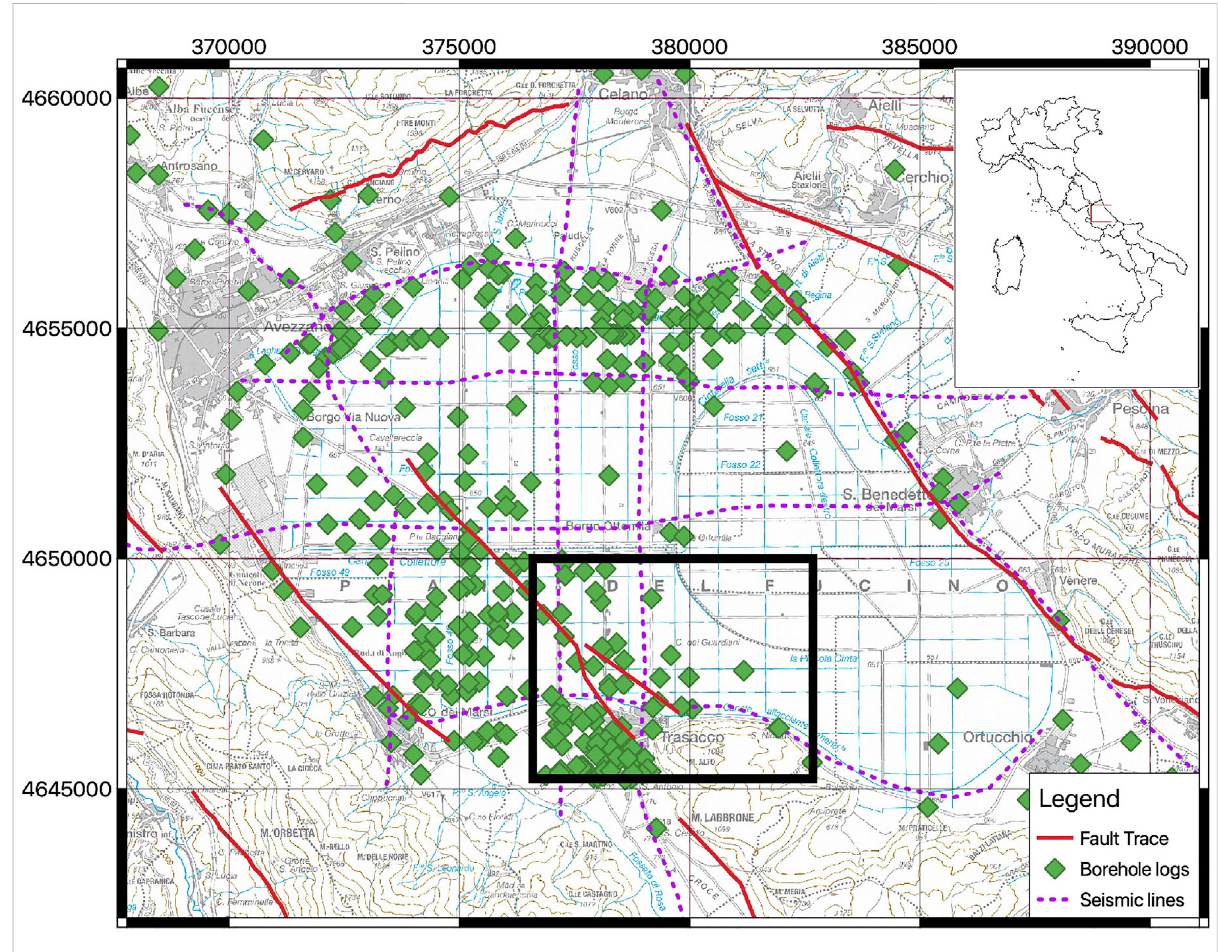
FIGURE 2 Mapofpreviousinvestigations:thefaultlinesfromtheITHACAdatabaseareinred,andboreholesfromISPRAandEnteFucino areingreen.The study area is delimited by a black